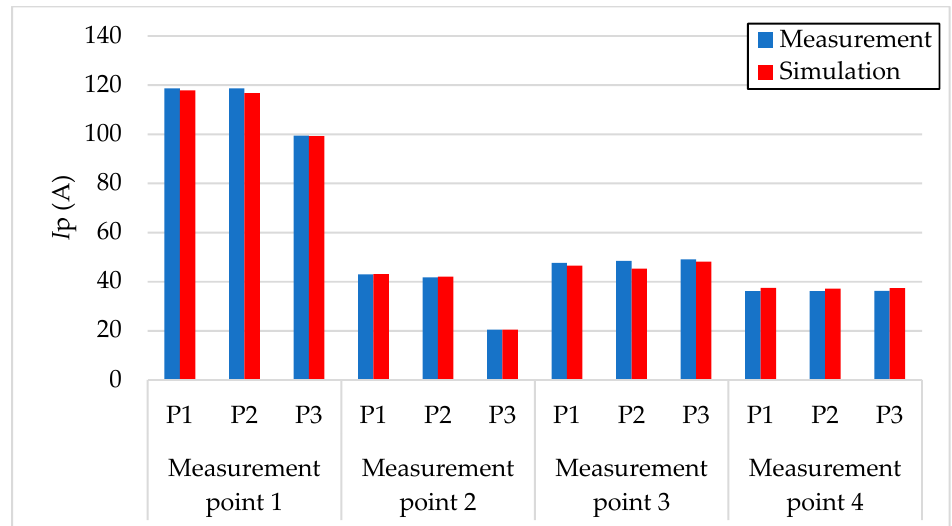
Figure 32. Voltage levels at the measurement points in the distribution grid.